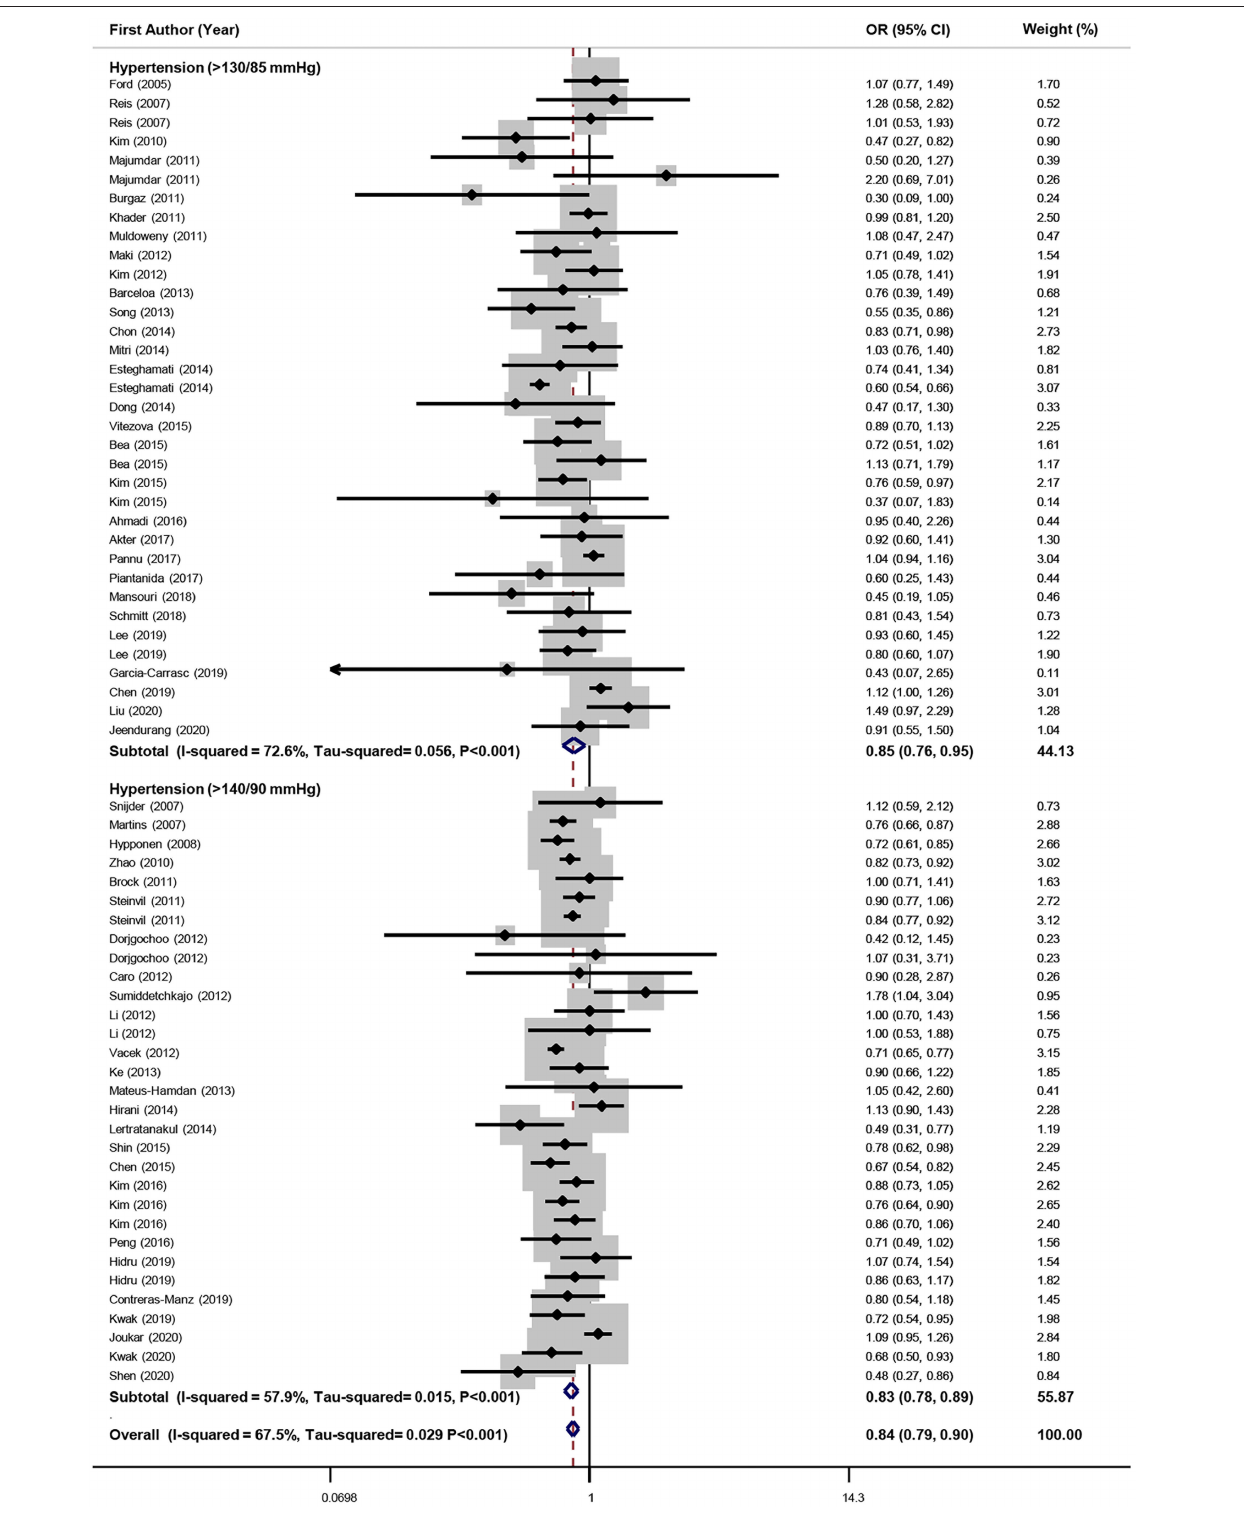
Frontiers in Nutrition |